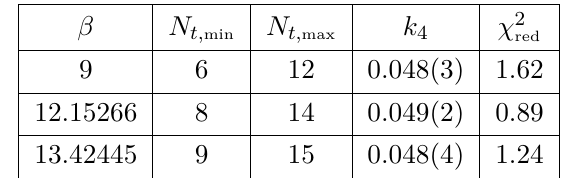
Figure 5 . Same as in figure 4, but for the data at β = 12 . 15266 .